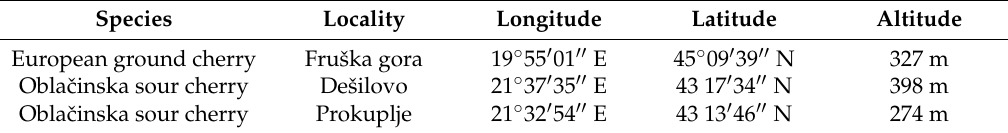
Table 1. Sampling locations coordinates and altitudes for investigated cherry